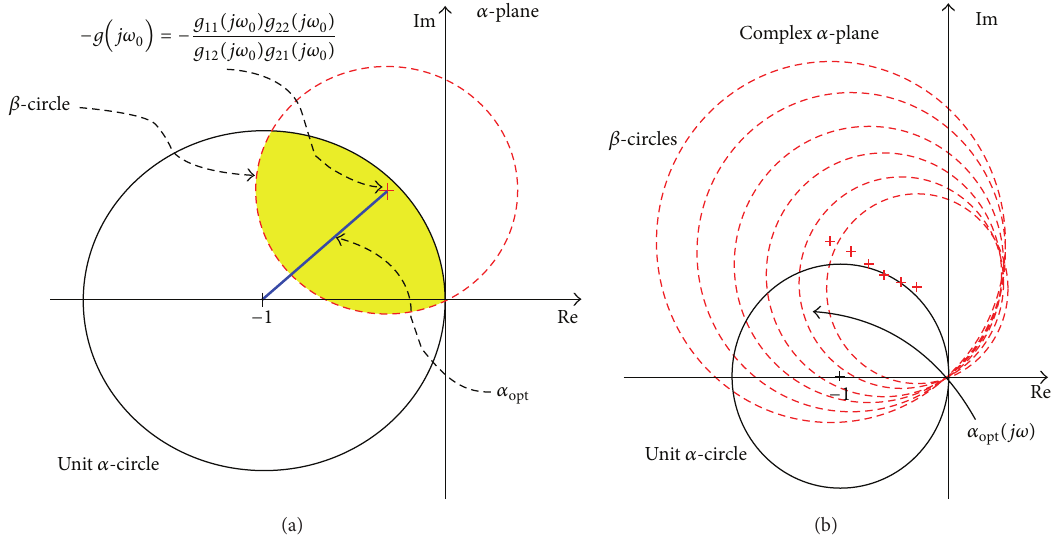
Figure 4: (a) Mapping of |𝛽(𝑗𝜔) + 1| < 1 ; (b) optimal solution 𝛼 opt (𝑗𝜔) on the complex 𝛼 - 𝑝𝑙𝑎𝑛𝑒 for broad band control.